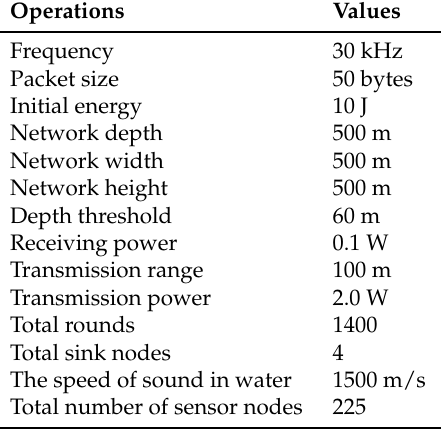
Table 3. Simulation